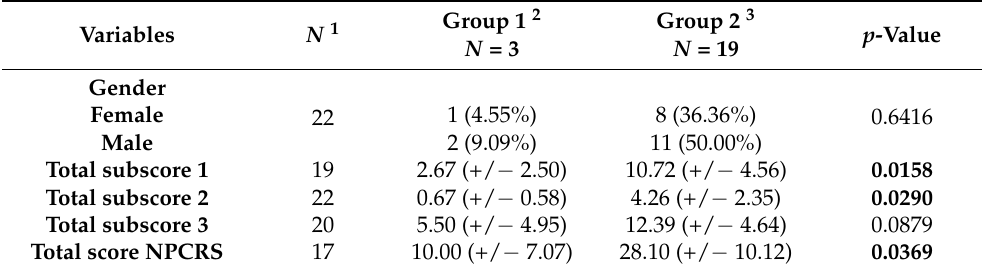
Table 4. Subscores and total Nijmegen score in patients with p.Cys241Ser together with one non- functioning allele and patients with one non-functioning